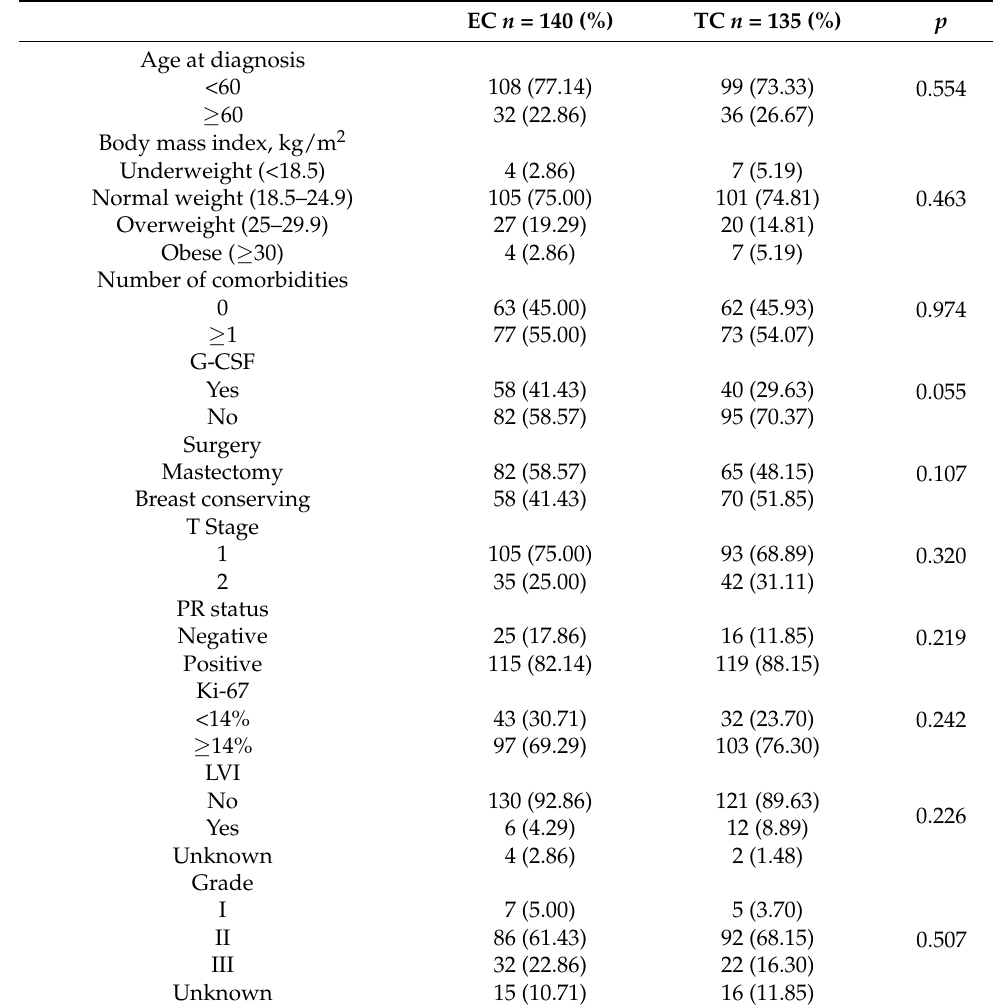
Table 1. The patient and treatment characteristics by arm (safety